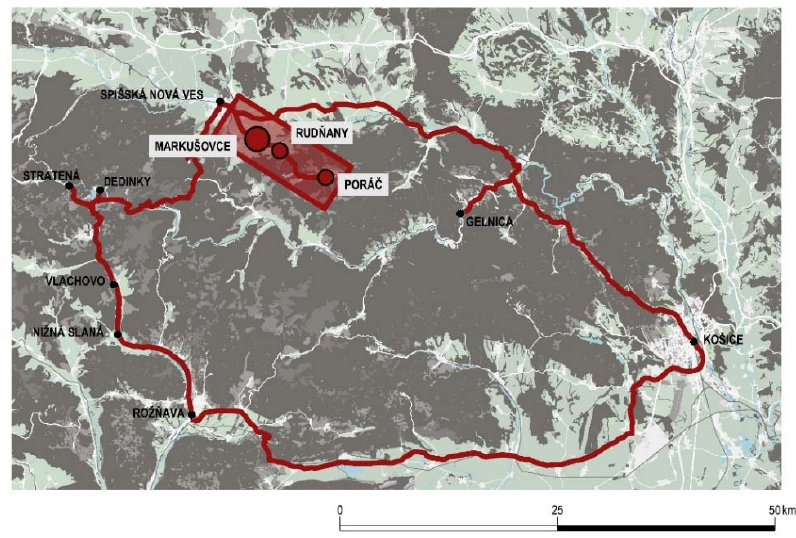
Figure 16. Trail model—application in the solved territory (figure from the